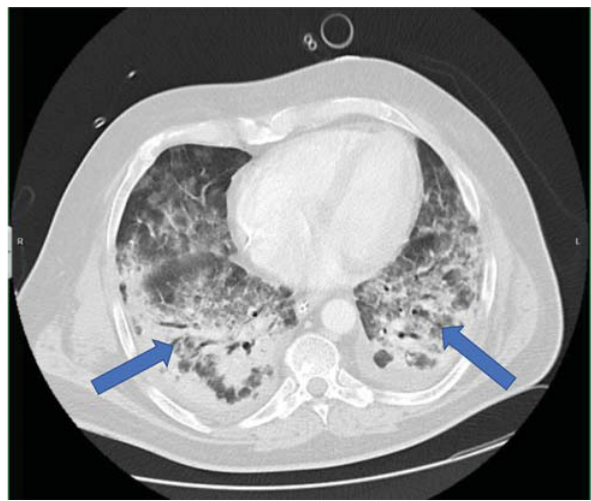
Fig. 1 Extensive bilateral lung in fi ltrates (blue arrows) associated with SARS-CoV-2 infection typical for corona-associated adult respi- ratory distress syndrome. SARS-CoV-2, severe acute respiratory syn- drome – coronavirus-2.